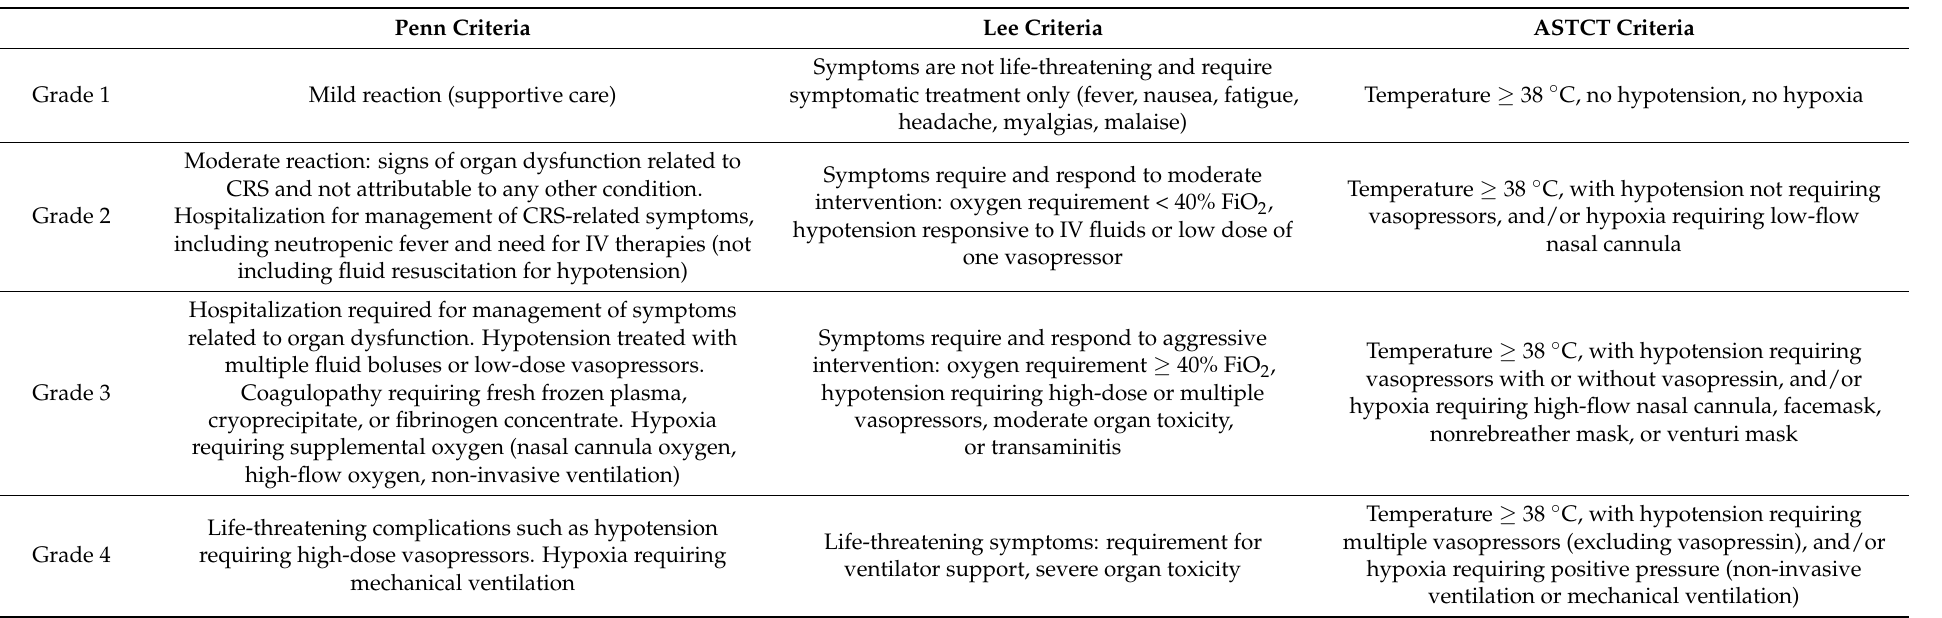
Table 1. Cytokine release syndrome (CRS) following CAR-T therapy: grading and clinical